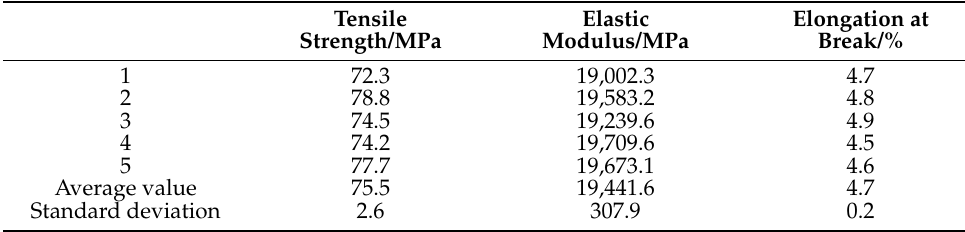
Table 5. Data of testing tensile property for the cured film.